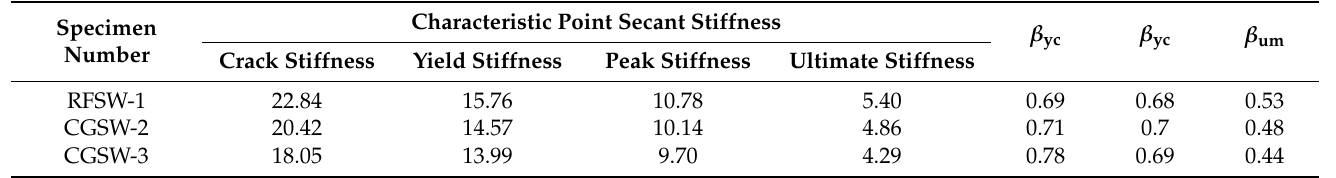
Table 8. Characteristic point secant stiffness of the specimens.